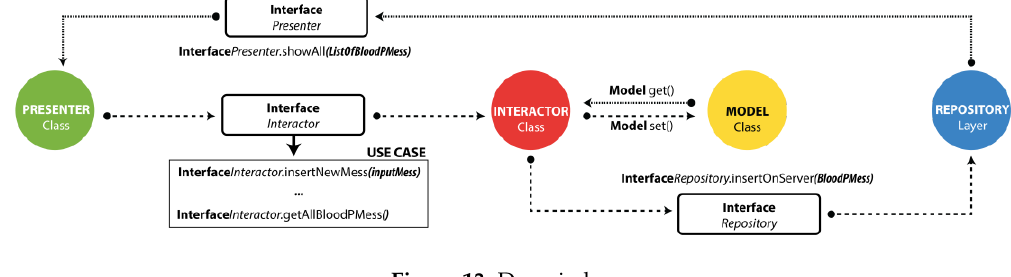
Figure 13. Domain layer.